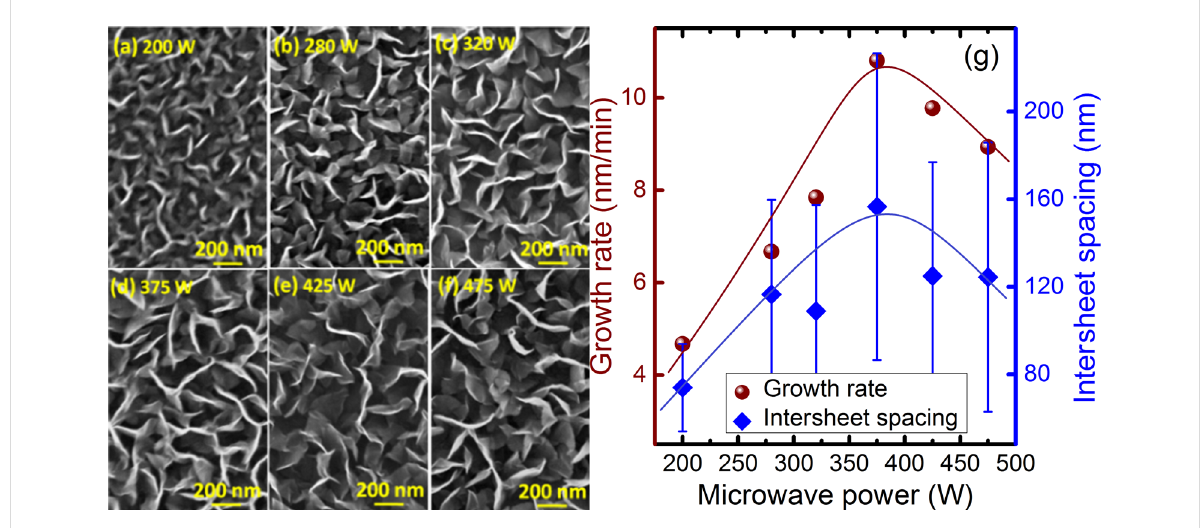
Figure 7: Scanning electron micrographs of VGNs grown at microwave powers of (a) 200 W, (b) 250 W, (c) 320 W, (d) 375 W, (e) 425 W and (f) 475 W; (g) variation of the growth rate and intersheet spacing as a function of the microwave power. Solid lines are to guide the eye.